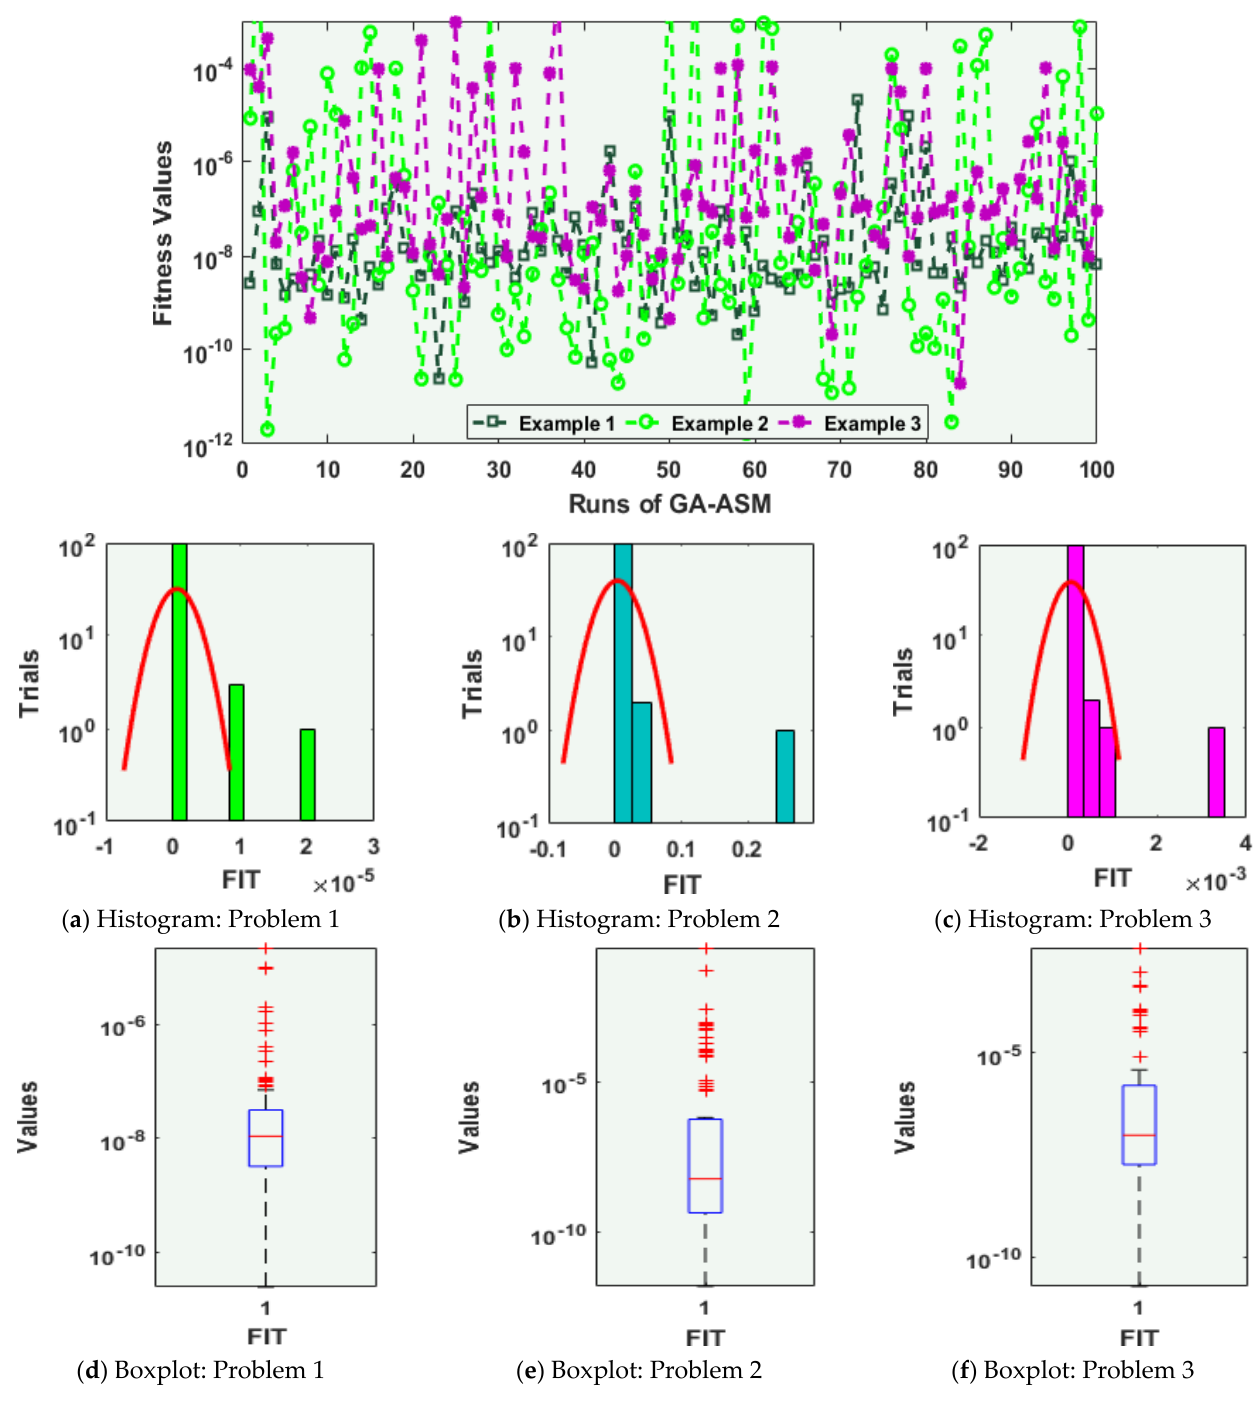
Figure 4. Convergence performances for the solution of Problems 1–3 based on the second kind of NLE-PDSM using ANN-GAASM in terms of FIT values; boxplots and histograms for 10 neurons. Fitness on y -axis and independent executions on x -axis.